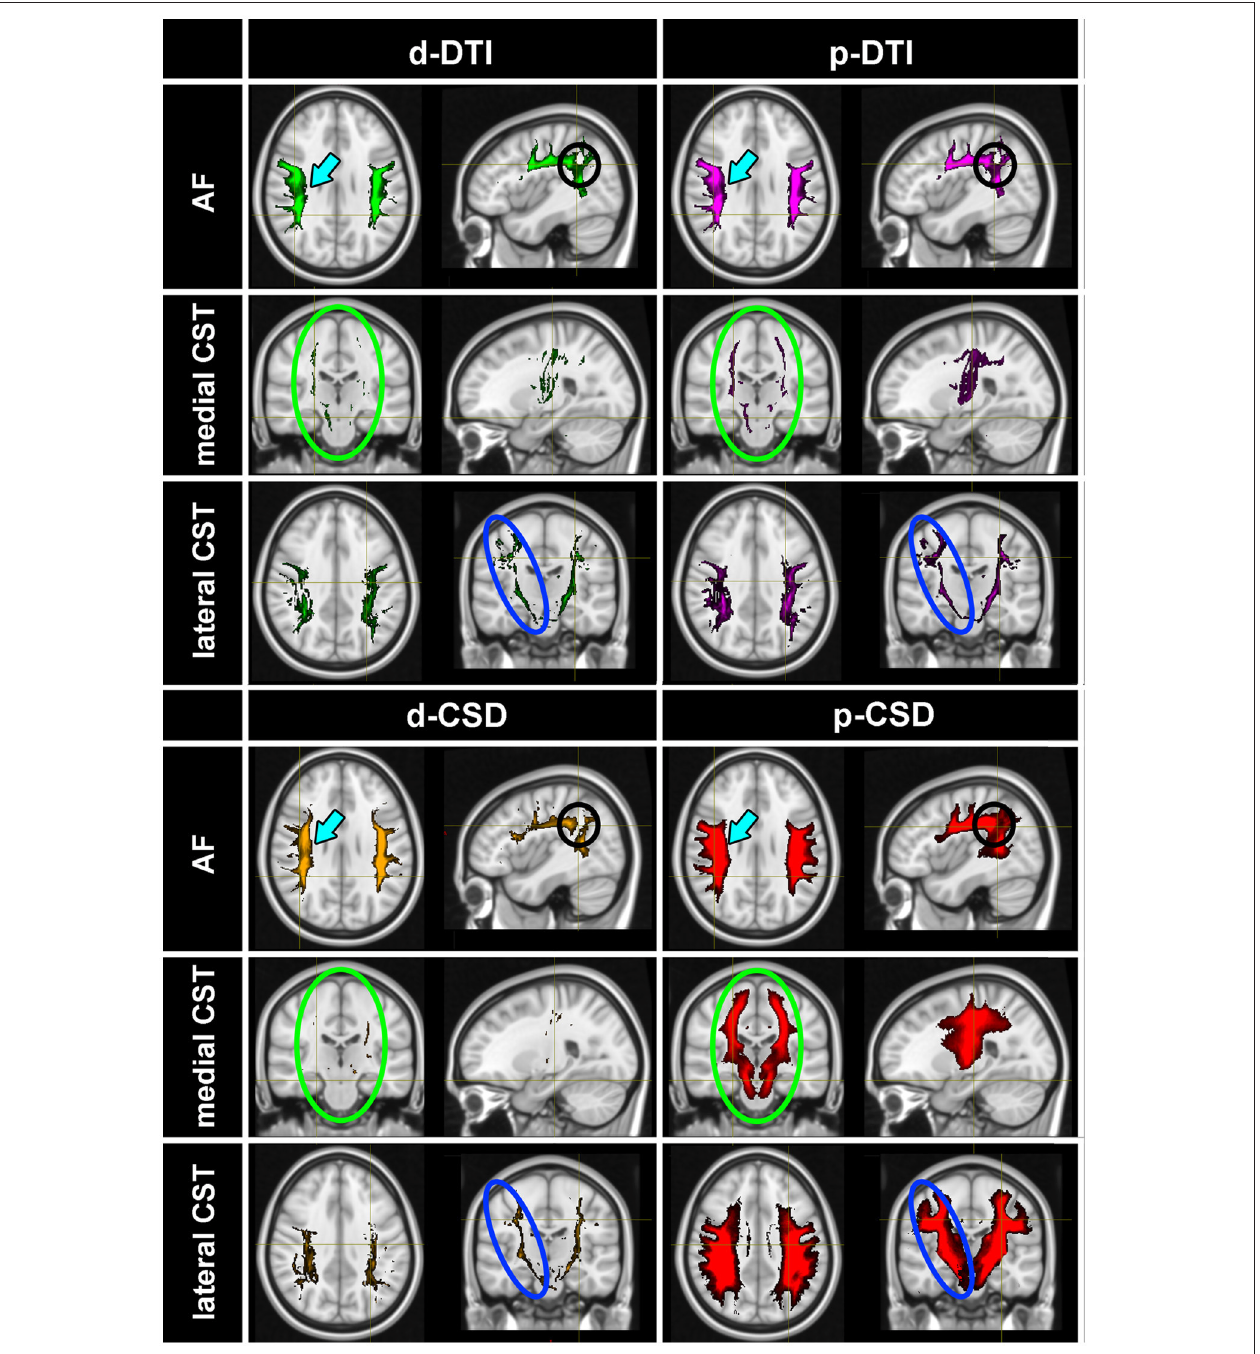
FIGURE 2 | Tractographic results. TDIs maps (thresholded at 5% of the maximal density) obtained from all subjects were warped and averaged in the MNI space for each method: p-CSD (red) related TDIs show the best results for AF, either in terms of tract definition (cyan arrows) as well as in the depiction of its curvature (black circles). p-CSD clearly outperforms DTI, shown with green and purple maps for deterministic and probabilistic results, in reconstructing medial (green circles) and lateral (blue circles) CST portions. Deterministic CSD (orange) is inadequate as well to produce robust reconstructions. AF, Arcuate Fasciculus; CST, Corticospinal Tract.